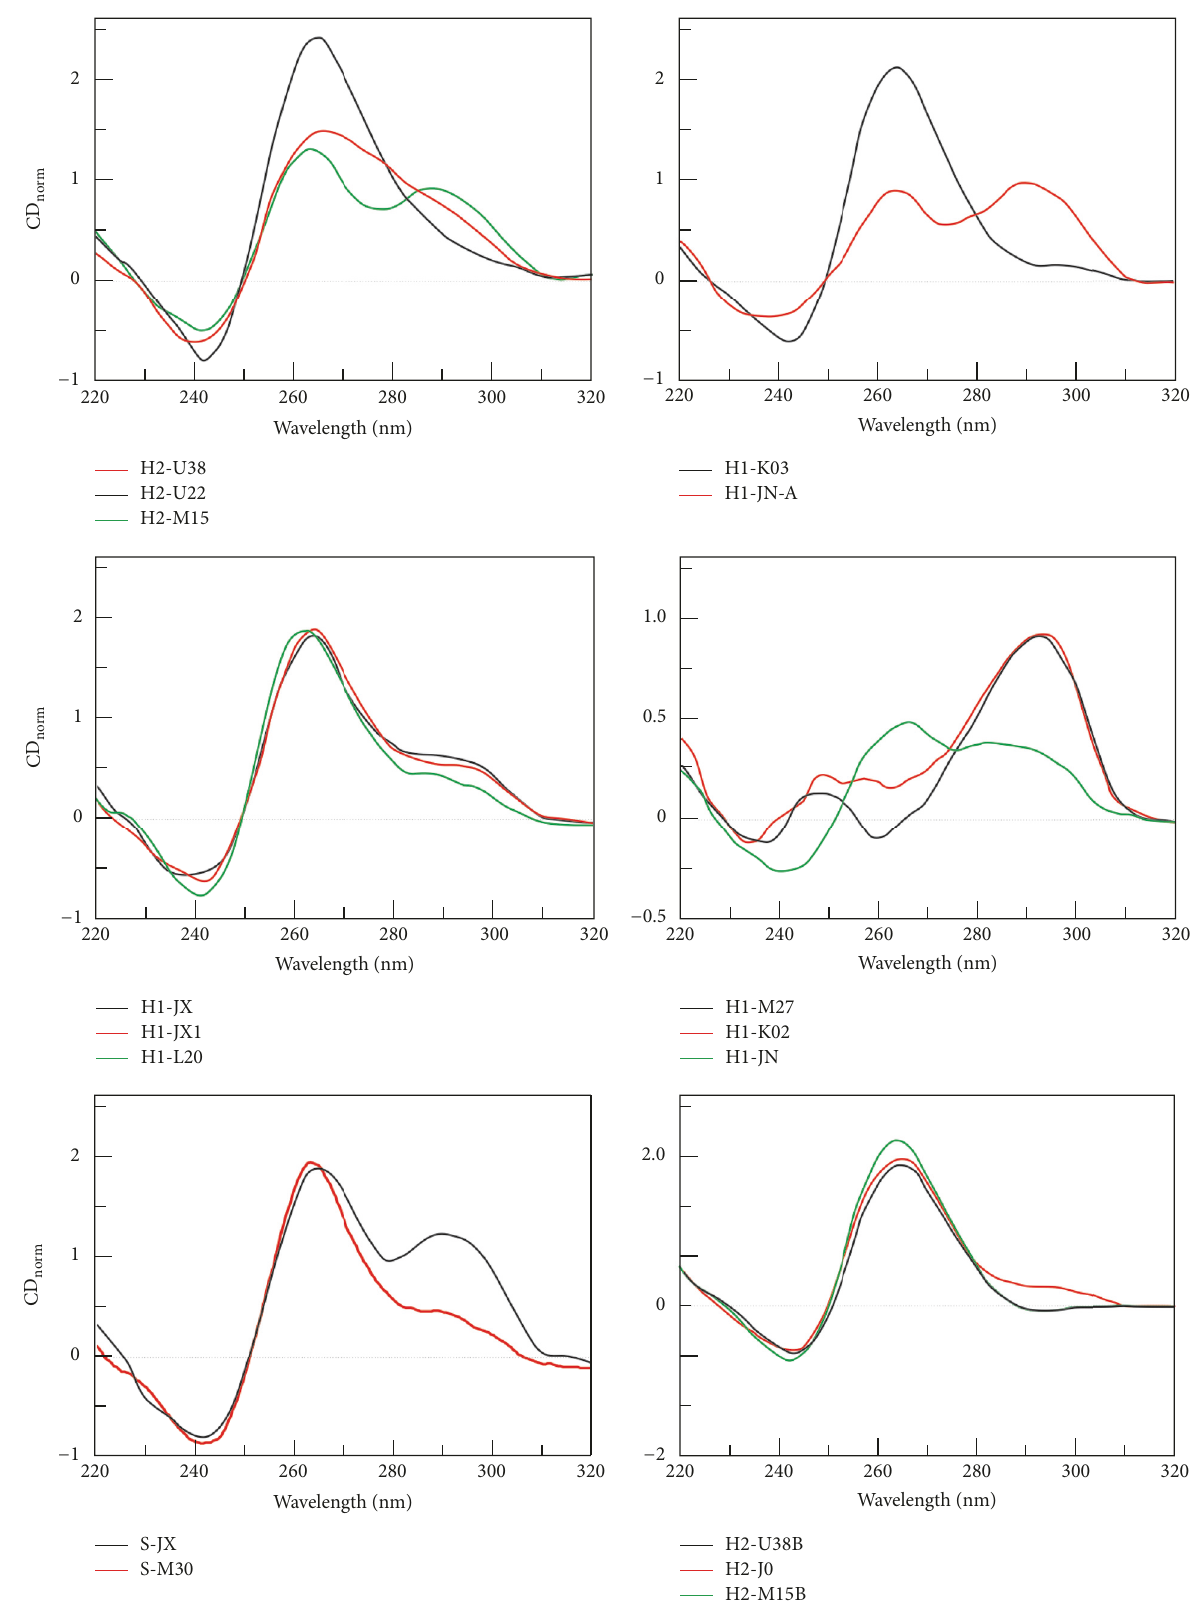
Figure 5: CD spectra of HIV oligomers in modified 25 mM mBR buffer (pH 7.0) in the presence of 50 mM KCl. The corresponding UV, TDS, and CD melting curves obtained at 265 and 293 nm are shown in Supporting Figures S1 and